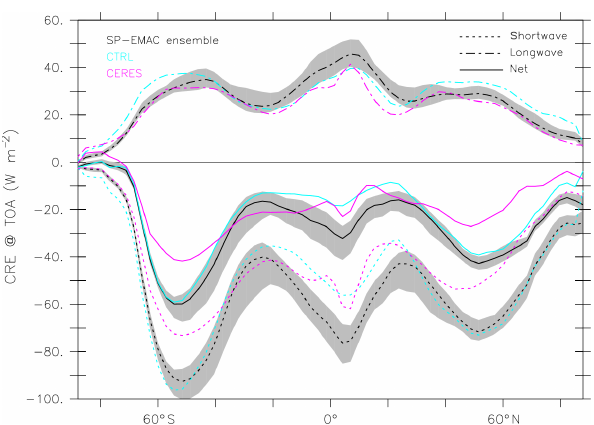
Figure 7. Zonal-averaged simulated top-of-atmosphere cloud radia- tive effects (CREs) compared to CERES EBAF-TOA data (2000–